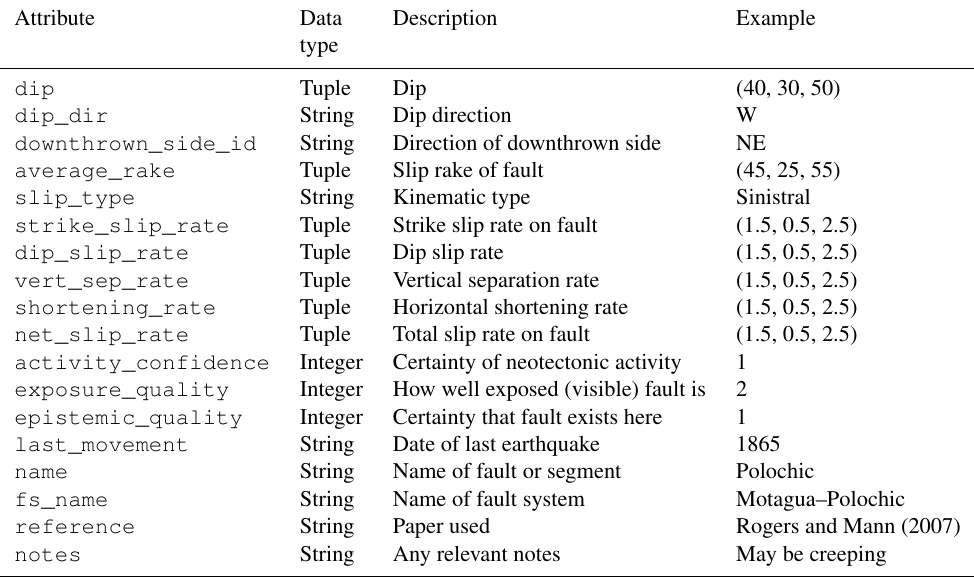
Table 1. Attributes for active structures. dip and rake are in degrees; strike_slip_rate , dip_slip_rate , vert_sep_rate , shortening_rate and net_slip_rate are in millimeters per annum; and other variables are categorical and